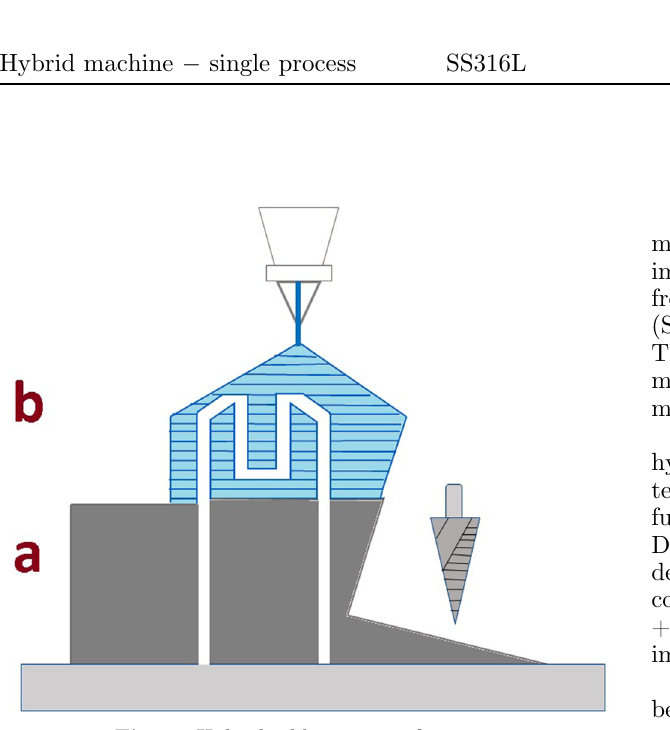
Fig. 3. Hybrid additive manufacturing.